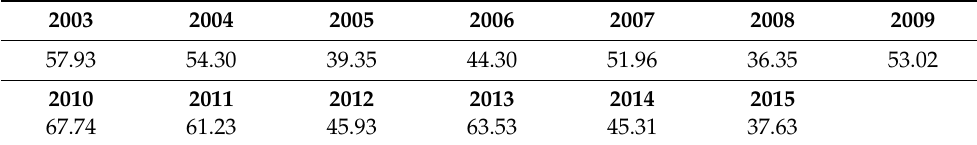
Table 3. Ratio of land sales revenues to local fiscal revenues